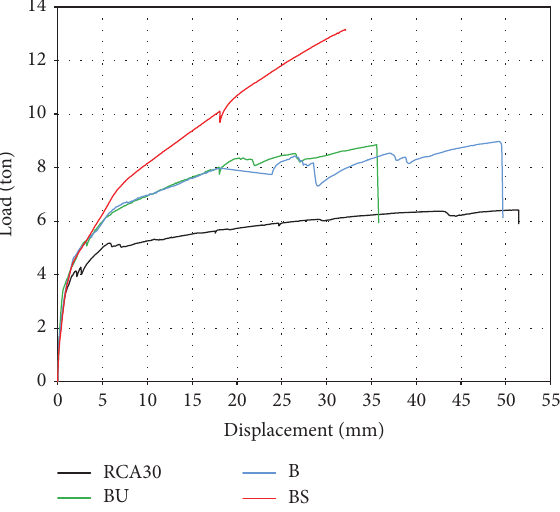
Figure 9: Specimen failure pattern (H40-RCA30-B).